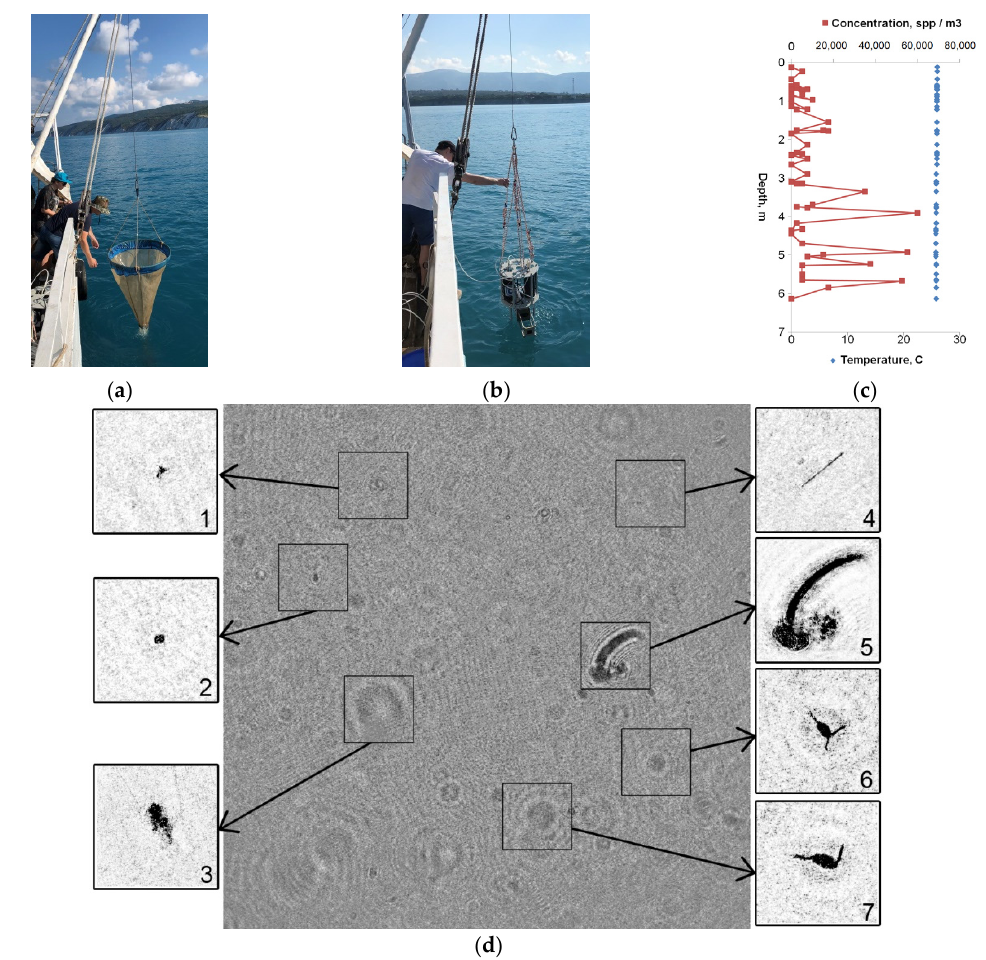
Figure 5. Equipment lowering in the Blue Bay on 25.06.19 from Ashamba research vessel: ( a ) Traditional plankton fishing using a net; ( b ) Hydrobiological probe with the miniDHC; ( c ) Profile of plankton concentrations (red) and one of the hydrophysical parameters (blue-temperature) recorded in situ in the photic layer and in real time. Measurements were made at station no. 1 with coordinates 44°34.3623 ′ N 37°58.7232 ′ E. ( d ) Digital hologram recorded at a depth of 1.8 m and reconstructed particle images: 1, 2—Suspension; 3—Marine snow; 4—Phytoplankton chain; 5—Copelata; 6, 7—Copepoda.